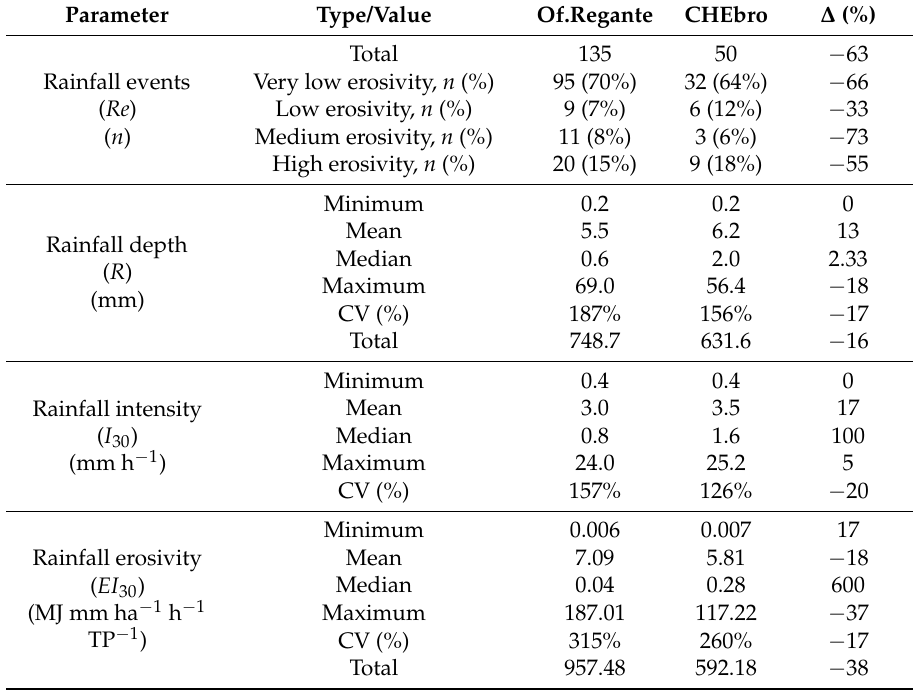
Table 3. Rainfall data and erosivity at the two weather stations during the 15-month test period (TP). Parameter Type/Value Of.Regante CHEbro ∆